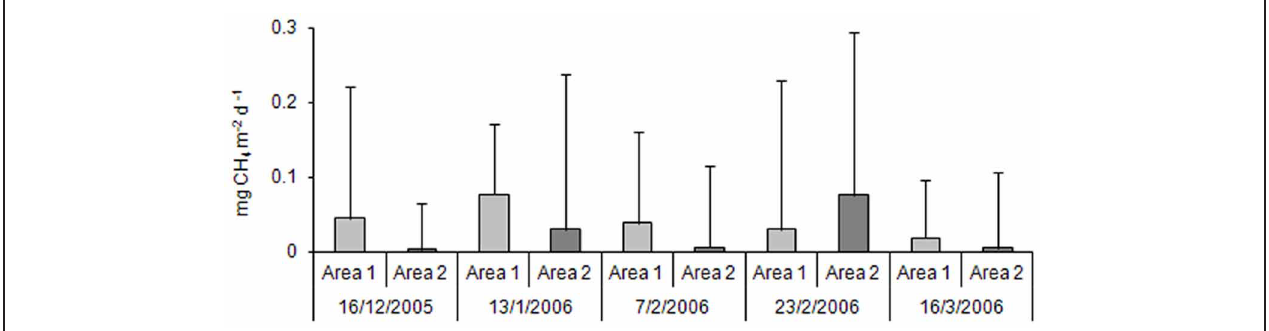
FIGURE 2 | Methane productions in the Area 1 and in the Area 2 throughoutthe rice crop cycle ( n =